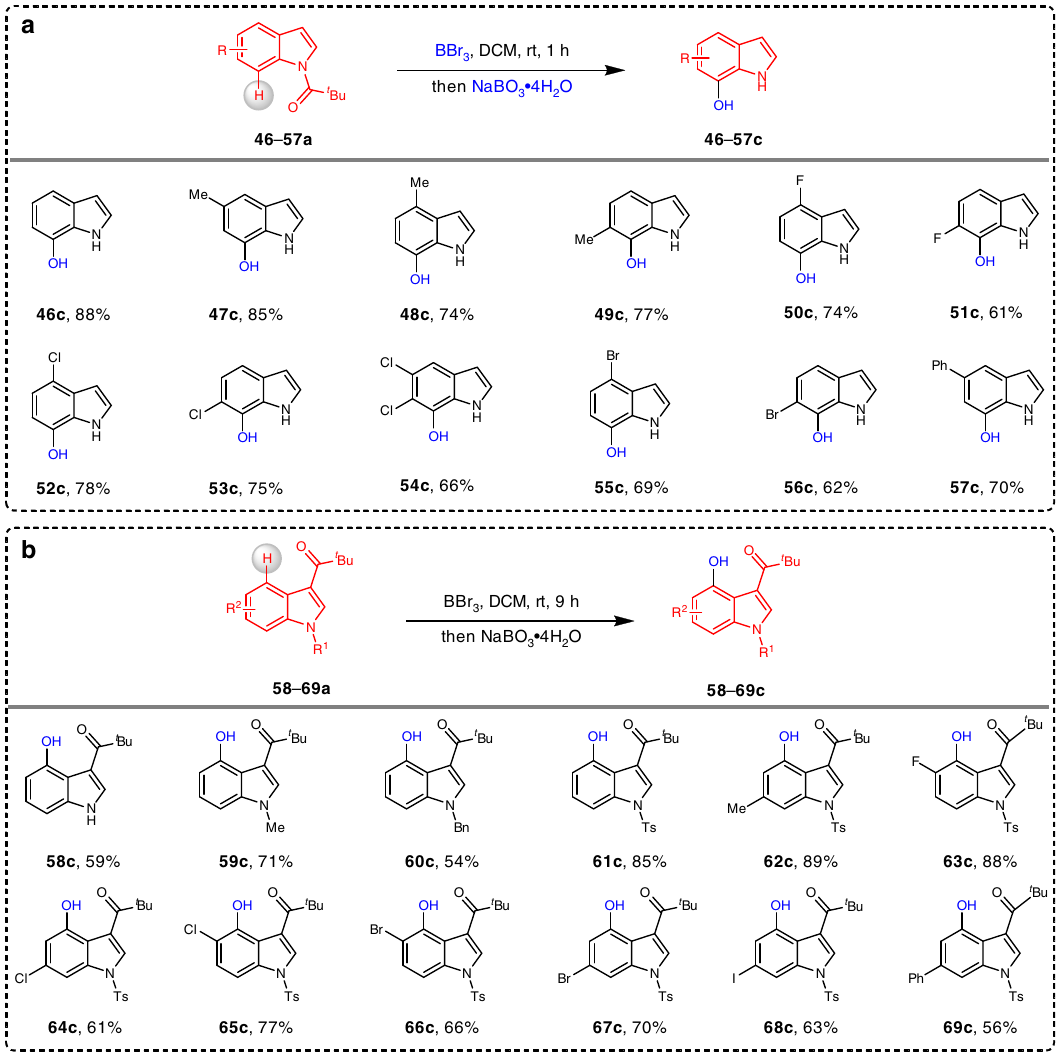
Fig. 3 Boron-mediated directed C – H hydroxylation of indoles. a Directed C – H hydroxylation of indoles at the C7 position. b Directed C – H hydroxylation of indoles at the C4 position. Reaction conditions: substrates 46 – 57a (0.20 mmol), BBr 3 (0.22 mmol) in 0.5 mL DCM at room temperature, 1 h, under Ar; NaBO 3 ·4H 2 O (0.60 mmol) in 0.5 mL THF and 0.5 mL K 2 CO 3 (aq), at room temperature, 1 h; 58 – 60a (0.20 mmol), BBr 3 (0.60 mmol) in 0.5 mL DCM at 60 °C, 10 h, under Ar; NaBO 3 ·4H 2 O (1.50 mmol) in 0.5 mL THF and 0.5 mL H 2 O, at 60 °C, 6 h; 61 – 69a (0.20 mmol), BBr 3 (0.22 mmol) in 0.5 mL DCM at room temperature, 9 h, under Ar; NaBO 3 ·4H 2 O (1.0 mmol) in 0.5 mL THF and 0.5 mL H 2 O, at room temperature, 2